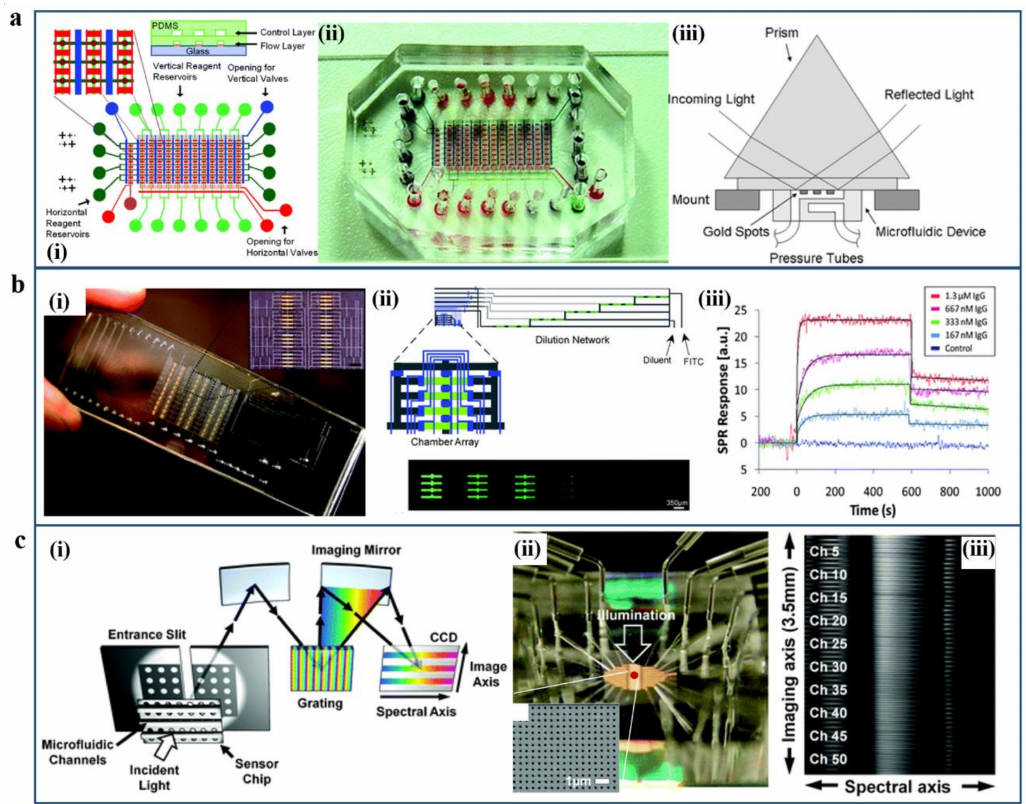
Figure 8. Examples of SPRi-based plasmonic sensing platforms. ( a ) Immunoassays by microfluidic-integrated SPRi sensing device. ( i ) The layout of the microfluidic device. ( ii ) Visualization photographs consist of valves and flow channels in the microchip device. ( iii ) The schematic illustration of the setup for a microfluidics-based SPR imaging device. Reproduced with permission from [113]. Copyright 2008 Royal Society of Chemistry. ( b ) Parallel microfluidic surface plasmon resonance imaging arrays. ( i ) Photograph of the microfluidic chip bonded to a gold-patterned glass slide. ( ii , iii ) Schematic diagram and fluorescence images of the serial dilution network and the chaotic advection micromixers on the chip. Reproduced with permission from [114]. Copyright 2010 Royal Society of Chemistry. ( c ) Fifty microfluidic channels-based real-time full-spectral SPRi sensing platform for affinity measurements. ( i ) Schematic illustration of the spectral imaging system setup. ( ii ) Photograph of inlet and outlet ports of the microfluidic chip; inset is the SEM image of an area of the nanohole chip. ( iii ) Fifty parallel channels of full spectral content imaging. Reproduced with permission from [115]. Copyright 2012 Royal Society of